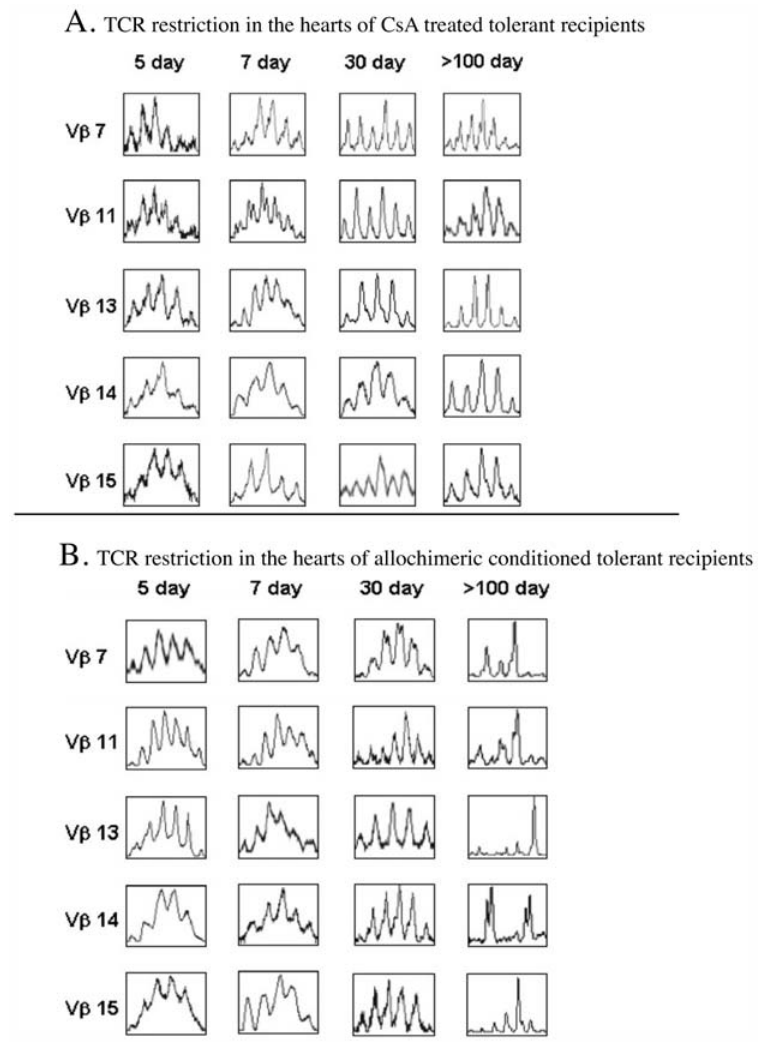
Figure 4. The dynamic alteration of T cell receptor repertoire in CsA (A) and allochimeric conditioned (B) long-term tolerant hosts. RNAs from heart allografts were harvested at different time points after transplantation followed by TCR detection. There were . 7 samples for each time-point.(B) (A) There was no TCR restriction in the hearts of CsA treated tolerant recipients throughout the whole period of long-term tolerance ( . day 120). (B) There was no TCR restriction in the hearts of allochimeric protein-treated tolerant recipients until 30 days post-transplantation. However, the V b 7, 11, 13, 14 and15 were highly restricted and occurred as the dominant peaks 84 days after transplantation. This restriction was maintained throughout the whole period of long-term tolerance ( . day